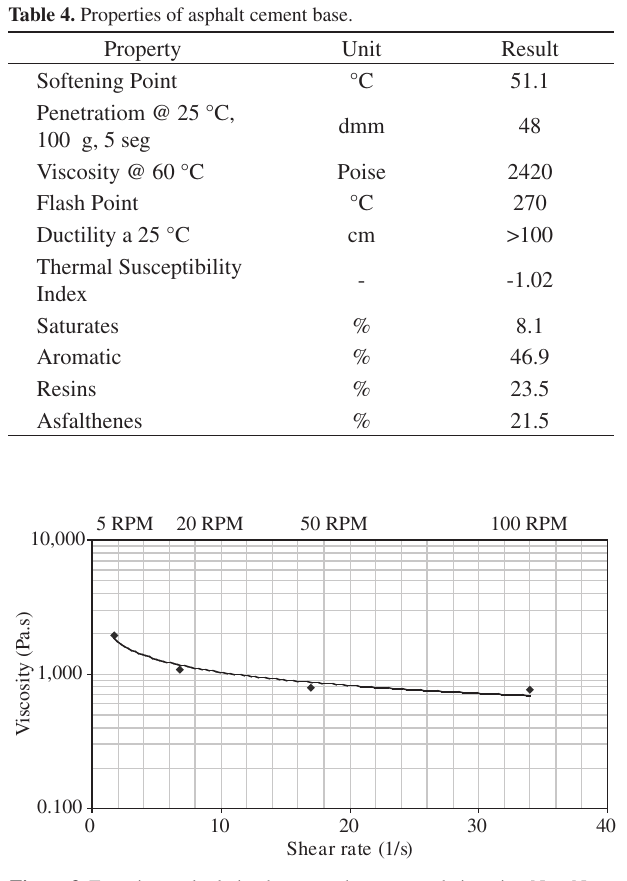
Figure 4. Surface η x RC x RT to statistical approach.